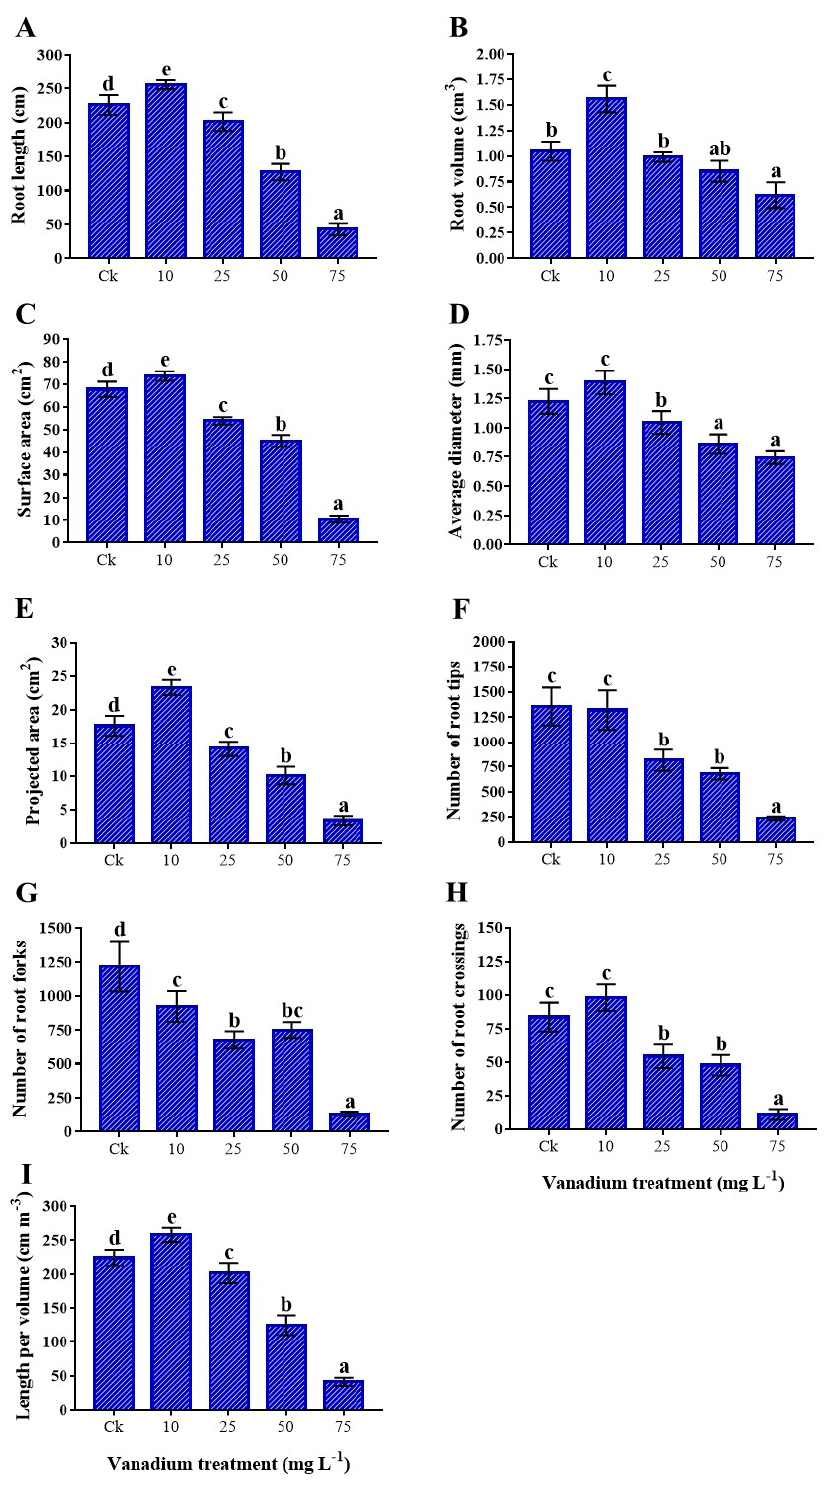
Figure 2. The influence of various V treatments on root morphological traits; ( A ) root length, ( B ) root volume, ( C ) surface area, ( D ) average diameter, ( E ) projected area, ( F ) number of root tips per plant, ( G ) number of root forks per plant, ( H ) number of root crossings per plant, and ( I ) root length per volume. Duncan’s test specifies a significant difference ( p < 0.05) between the means of the five treatments indicated by different letters.